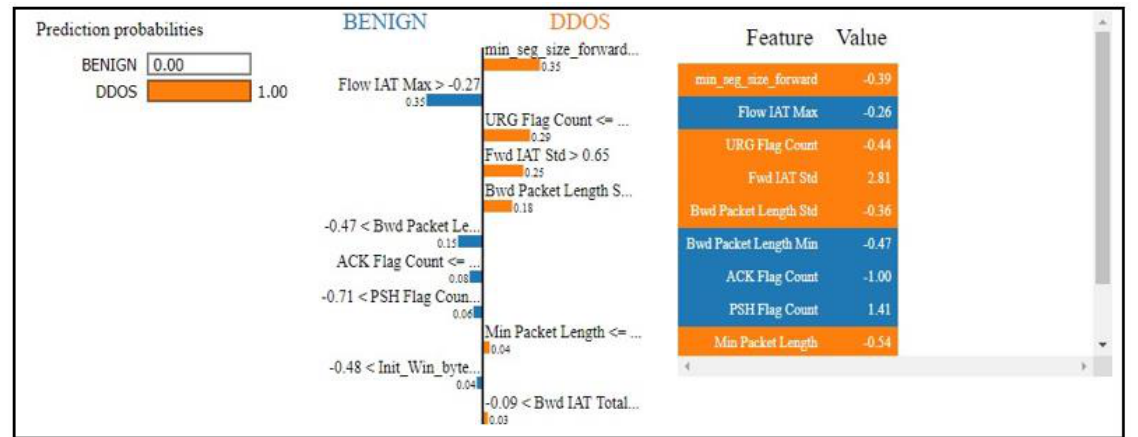
Figure 16. LIME observations for random forest.